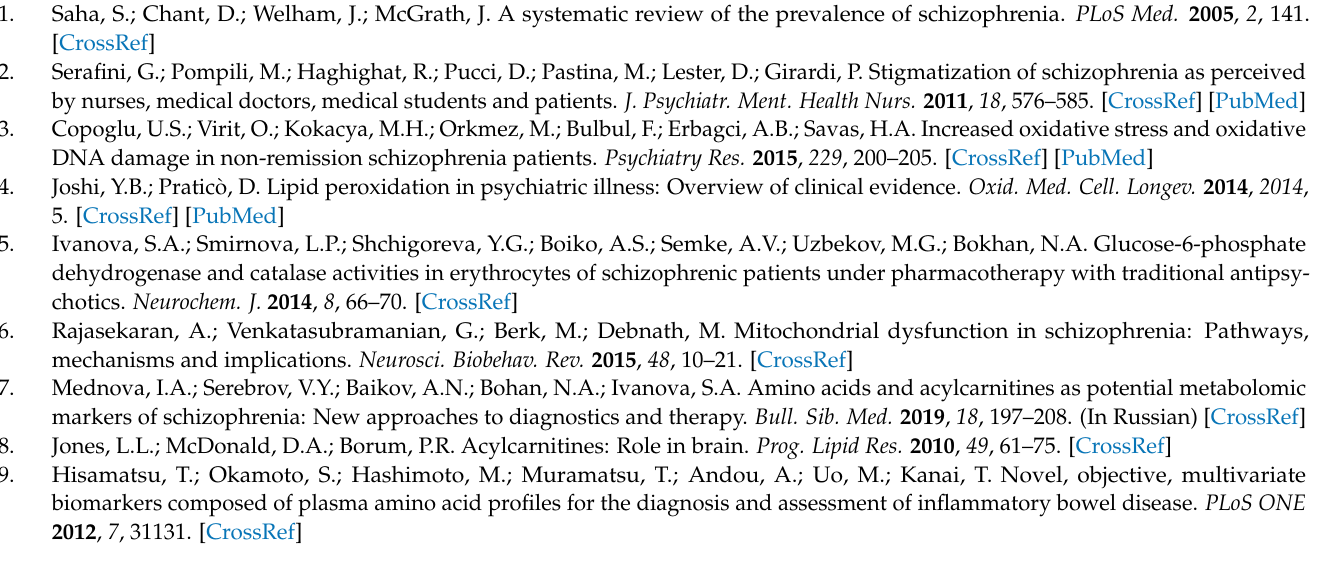
Figure A1. Metabolic pathway involving carnitine palmitoyltransferase I (CPT1) and O-long-chain-acyl-L-carnitine. The scheme is taken from the online resource metacyc.org with EC number 2.3.1.21. The Hs-CPT1C is associated with brain isoform of carnitine O-palmitoyltransferase 1.